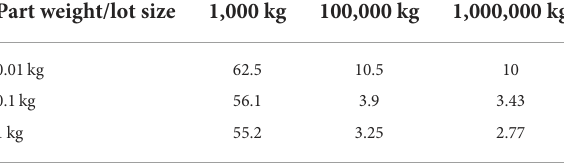
TABLE 4 TEA of PLA manufacturing for different part weights and lot sizes in $